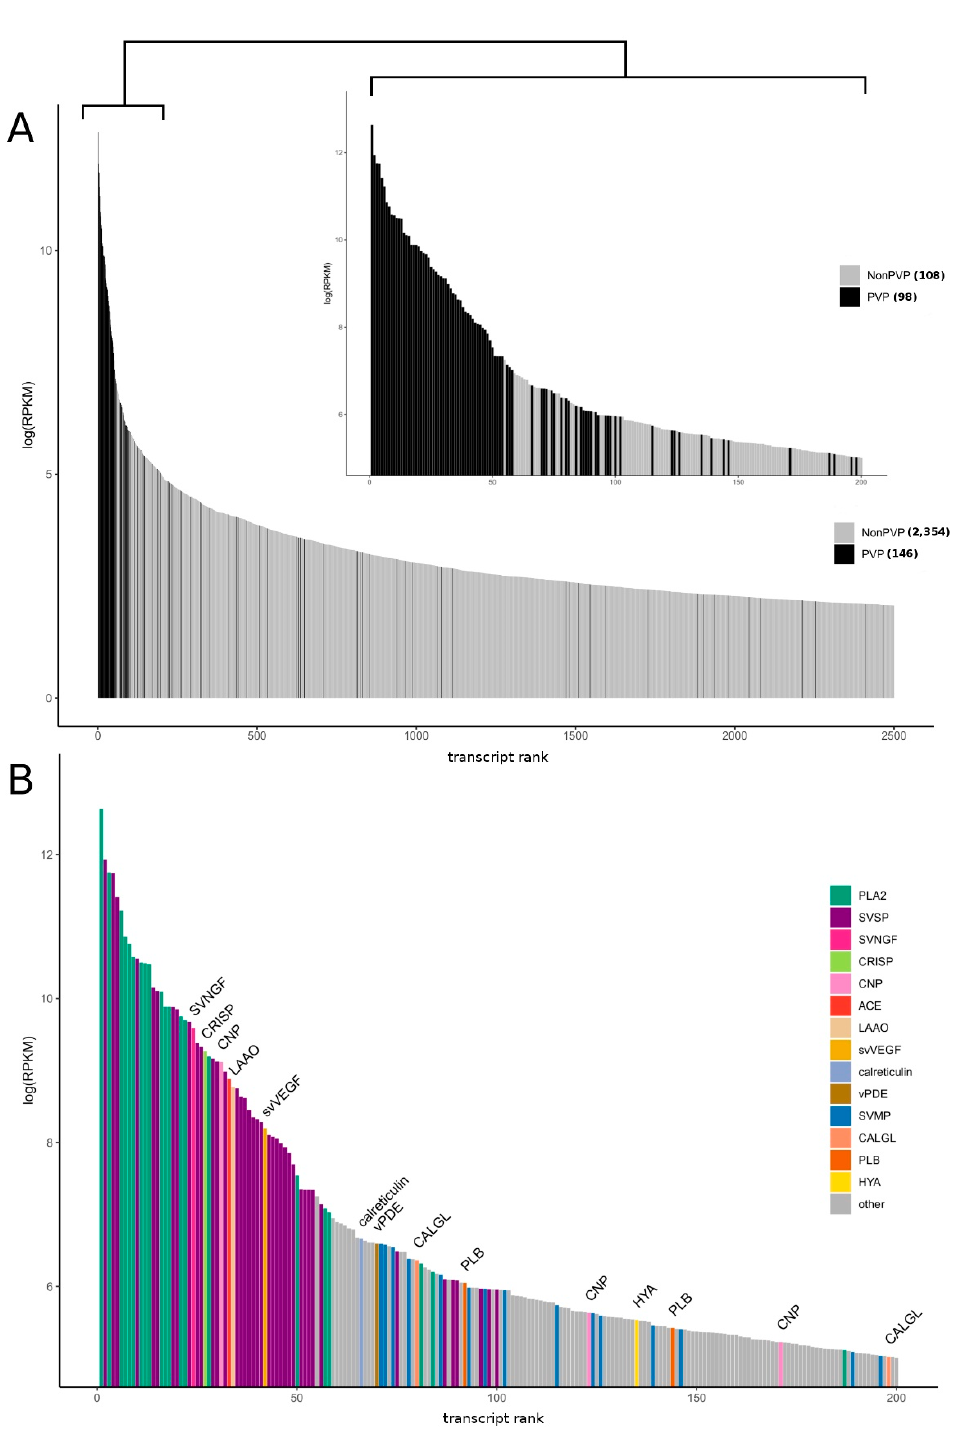
Figure 3. The overall expression patterns for the most abundant transcripts in A. feae venom gland tissue. ( A ) Expression of toxins and venom proteins (PVP—putative venom transcripts) dominates relative to other transcripts; ( B ) The venom-gland transcriptome of A. feae showed high expression and diversity of snake venom phospholipases A2 and serine proteinases. Expression levels of individual PVP transcripts are shown with toxin classes coded by color. Abbreviations: ACE—Angiotensinogenase, CALGL—Calmodulin, CNP—C-type natriuretic peptide (Azemiopsin included), CRISP—Cysteine-rich secretory protein, HYA—Hyaluronidase, LAAO—L-amino acid oxidase, PLA2—Phospholipases A2, PLB—Phospholipase B, SVMP—Snake venom metalloproteinase, SVNGF—Snake-venom nerve growth factor, SVSP—snake-venom serine proteinases, svVEGF—Vascular endothelial growth factor, vPDE—Venom phosphodiesterase